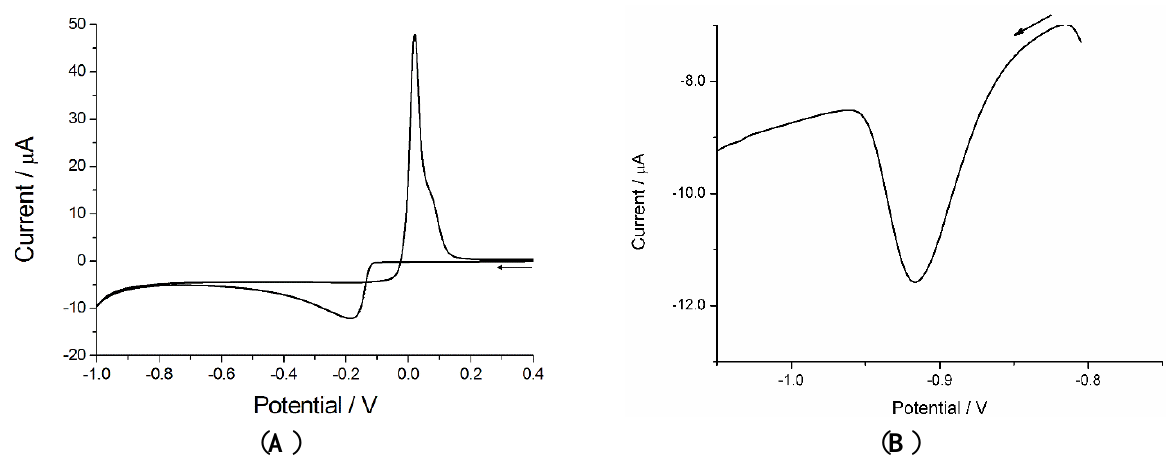
Figure 1. ( A ) Cyclic voltammogram recorded at a pyrolyzed photoresist electrode (PPCE) in 1 mmol∙L −1 Bi(NO 3 ) 3 , 0.1 mol∙L −1 acetate buffer (pH 4.5) solution. Scan rate 10 mV s −1 . ( B ) Typical adsorptive stripping voltammetry (AdCSV) of Ni(II) at an in situ prepared Bi-PPCE in 5 µg∙L −1 Ni(II) in 0.1 M ammonia buffer solution containing 10 mg∙L −1 Bi(III), 1 × 10 −5 mol∙L −1 DMG and 0.01 mol∙L −1 tartrate. Deposition at −1.1 V for 60